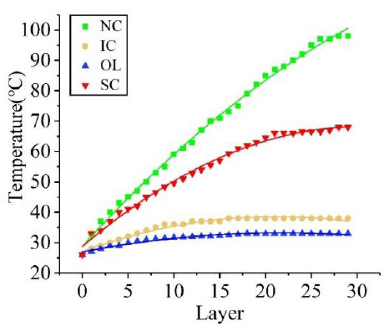
Figure 5. Temperature of each layer deposited by different cooling processes.